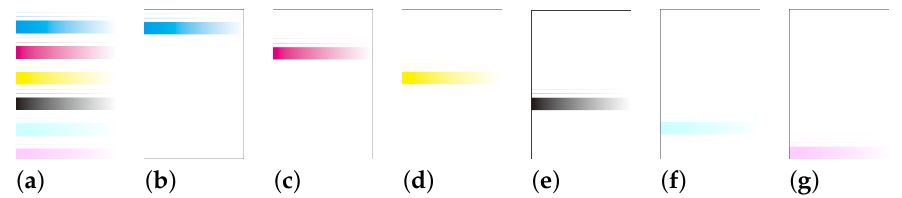
Figure 3. Experimental results of channel independence. ( a ) Gradual color separation image; ( b ) First; ( c ) Second; ( d ) Third; ( e ) Fourth; ( f ) Fifth; ( g )